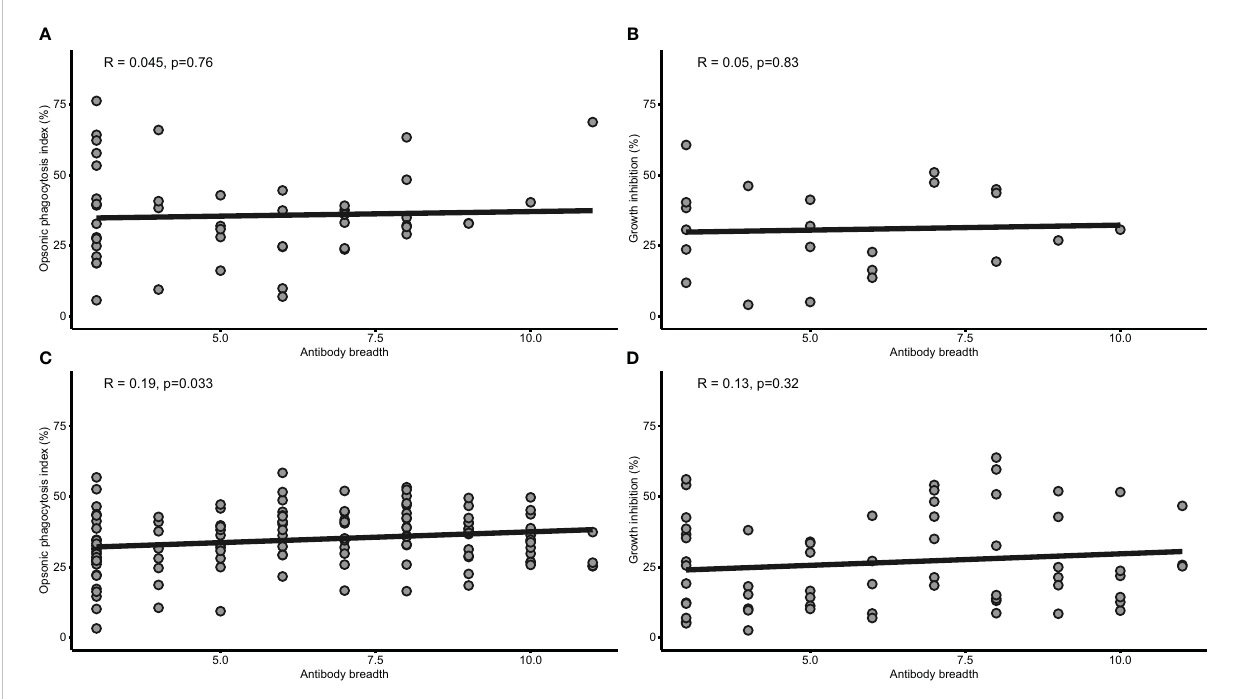
FIGURE 3 Antibody breadth is associated with both opsonic phagocytosis and growth inhibition. Scatterplots with linear regression lines are shown for the relationship between IgG antibody breadth and OP (n=79) (A) , and growth inhibition (n=22) (B) in children under fi ve years, and OP (C) and grown inhibition (D) in children above 5 years. The shaded area around the regression line is the 95% Con fi dence